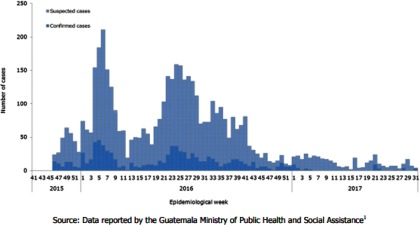
Suspected and Confirmed Zika Cases, Guatemala, Epidemiological Week 41 of 2015 to Epidemiological Week 31 of 2017Source: PAHO and WHO (2017).11